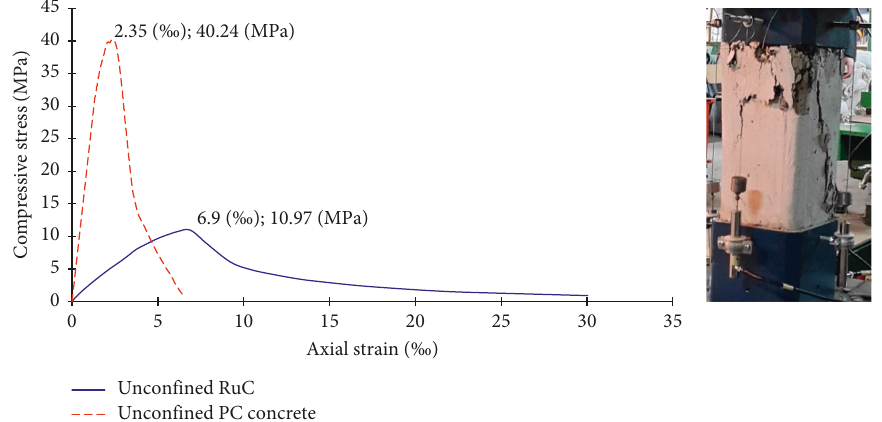
Figure 4: Complete stress-strain curve of normal and rubberized unconfined concrete columns and failure